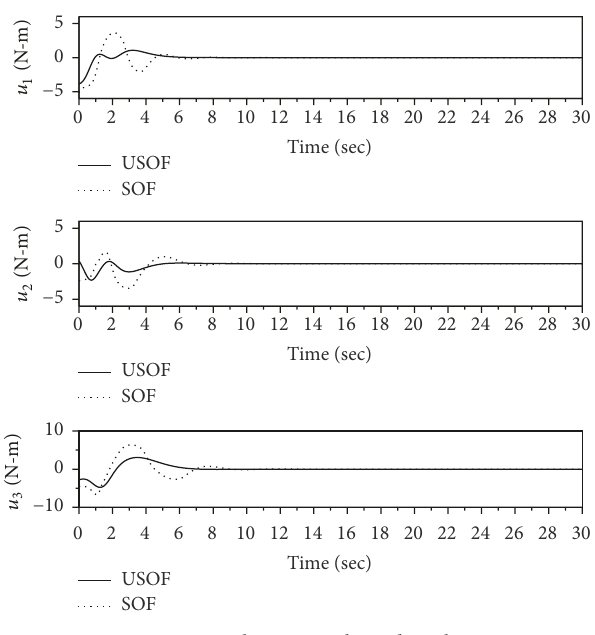
Figure 3: Control torque without